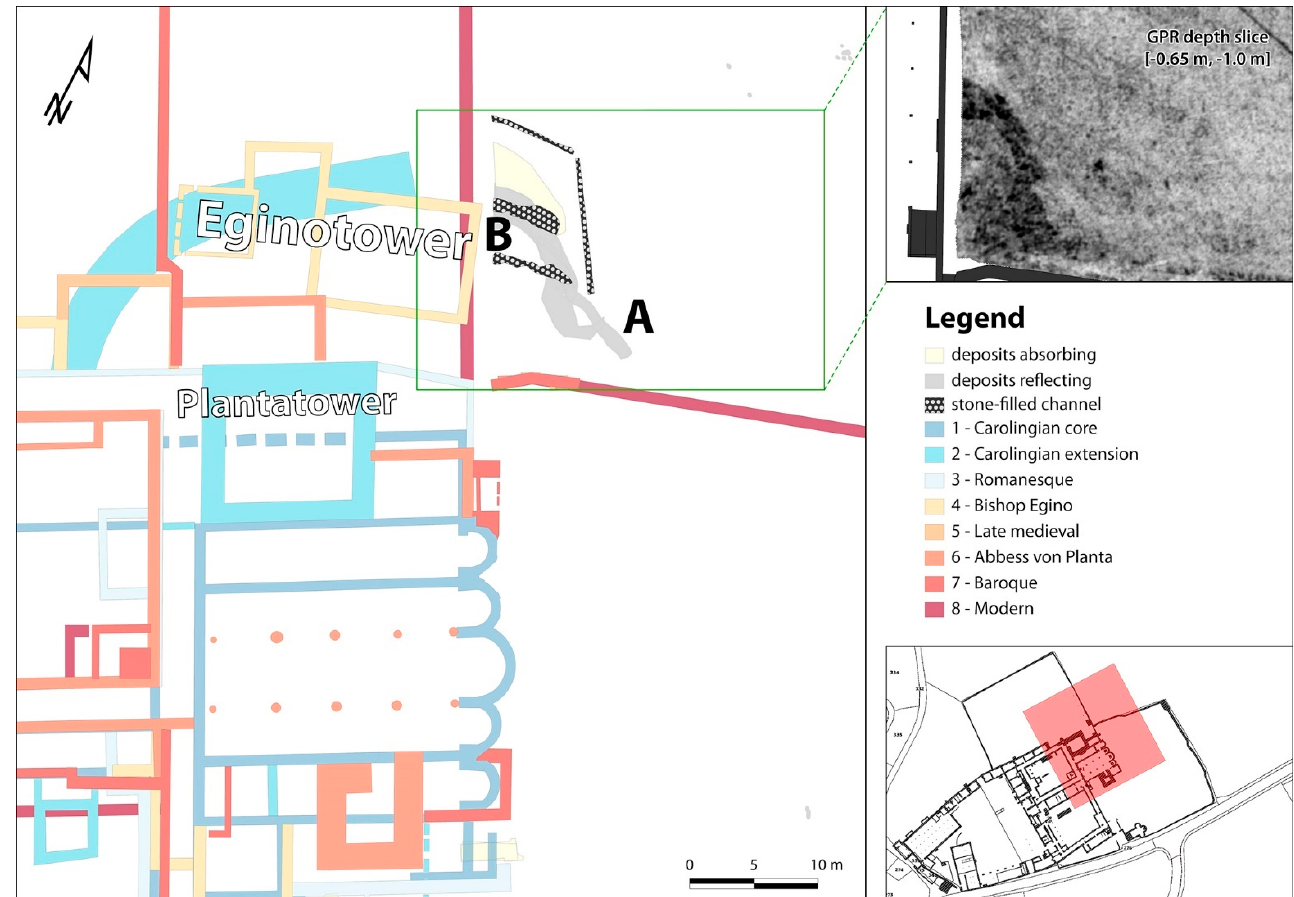
Figure 8. Overview of the known historical structures and the new prospection additions around the Planta- and Eginotower (see the text for A and B ).